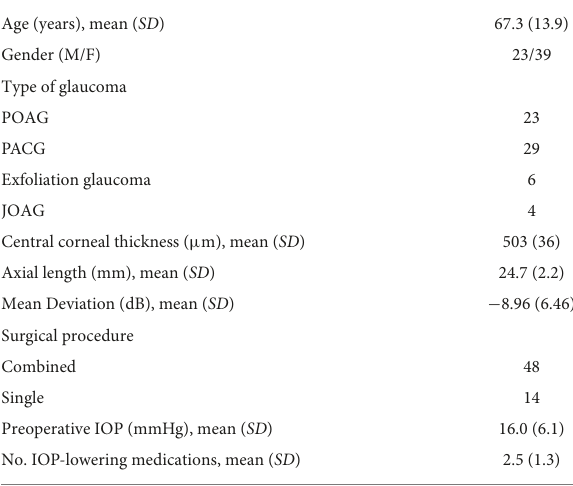
TABLE 1 Clinical characteristics of study